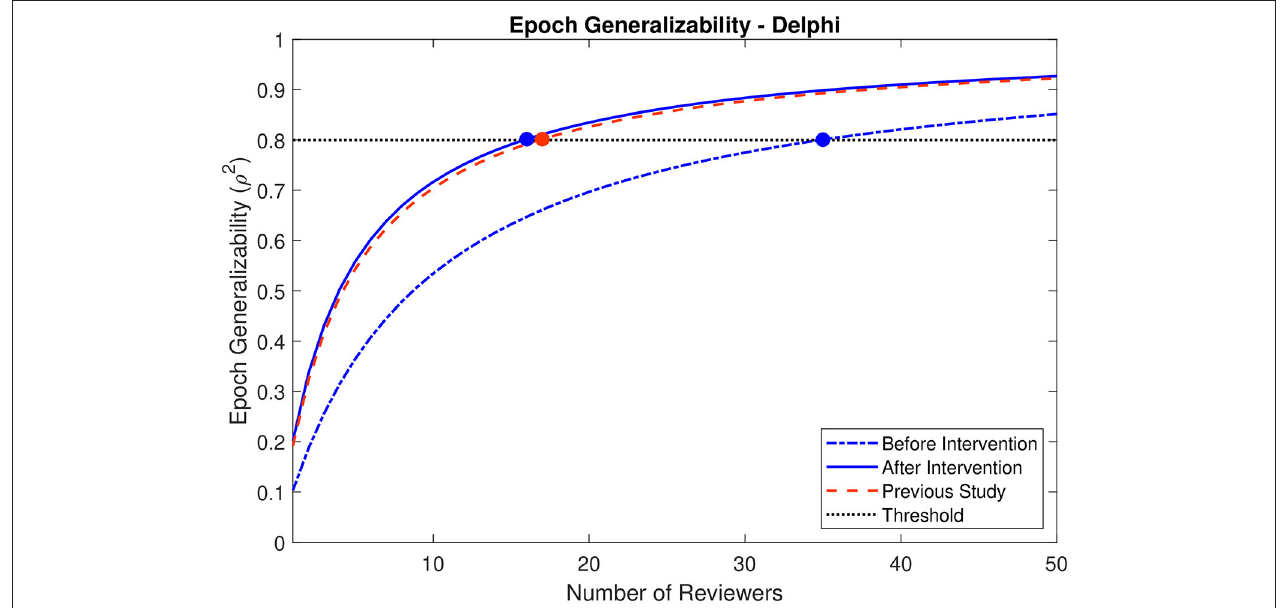
FIGURE 7 | Decision study projections for epoch generalizability before and after the Delphi-style intervention. Projections of the epoch generalizability based on the number of reviewers are presented for all 15 reviewers before (dot-dashed blue line) and after (solid blue line) the intervention. The decision study projections from the previous study ( 9) are indicated by the dashed red line. The threshold of 0.8 is indicated by the dotted black line, and the number of reviewers projected to be required to achieve the threshold in each case is indicated by a colored